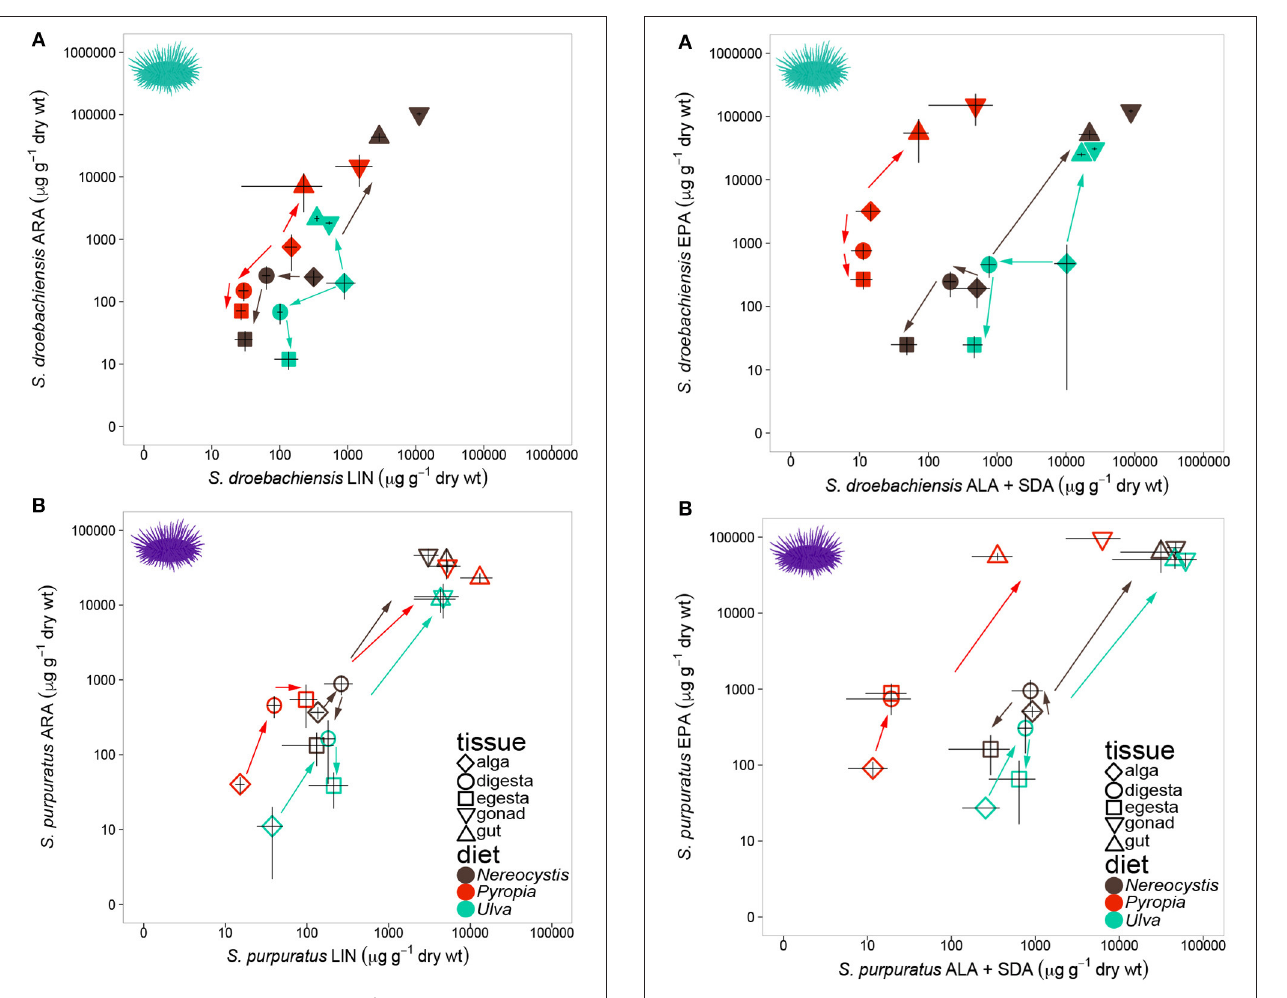
FIGURE 7 | Concentrations (mean ± SD , µ g g − 1 dry weight) of precursor FAs 18:3 ω 3 (ALA) and 18:4 ω 3 (SDA) and 20:5 ω 3 (EPA) in tissues collected from feeding assays with (A) S. droebachiensis and (B) S. purpuratus . Arrows indicate urchin modification of diet algae as they are digested and subsequently incorporated into new urchin tissue. Concentrations are plotted on a logarithmic